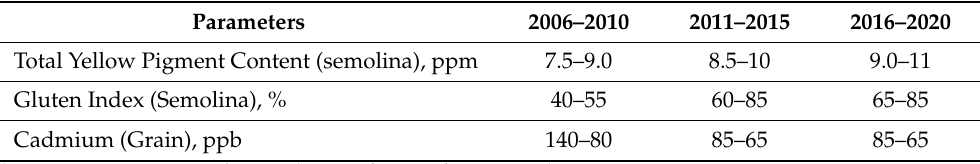
Table 1. Selected quality parameters of Canadian durum export aggregates.